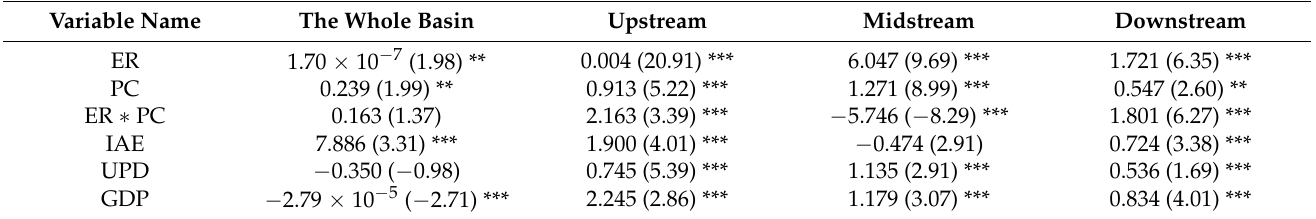
Table 4. The regression results of variables on the high-quality development efficiency of the Yellow River Basin 1